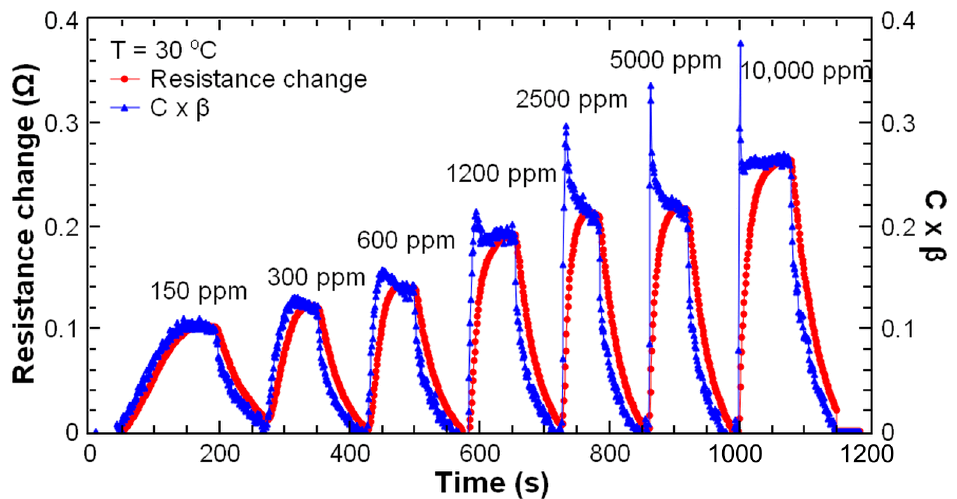
Figure 7. The measured resistance change ∆ R (red curve) and the calculated quantity C × β according to the presented model (blue curve), as a function of time, for different CO 2 concentrations. The temperature is 30 °C.